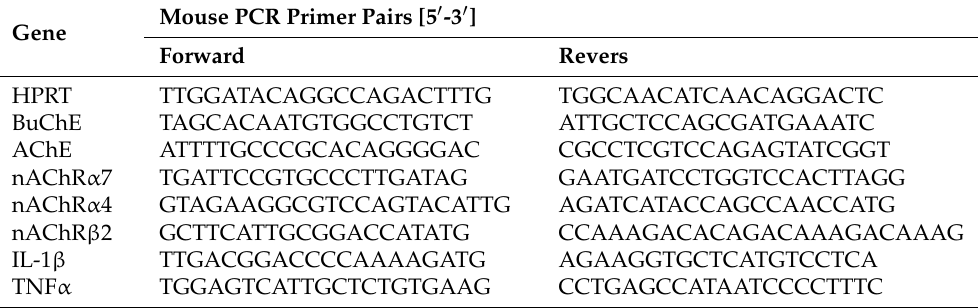
Table 8. Primer pair sequences used in the study. Mouse PCR Primer Pairs [5 (cid:48) -3 (cid:48) Gene